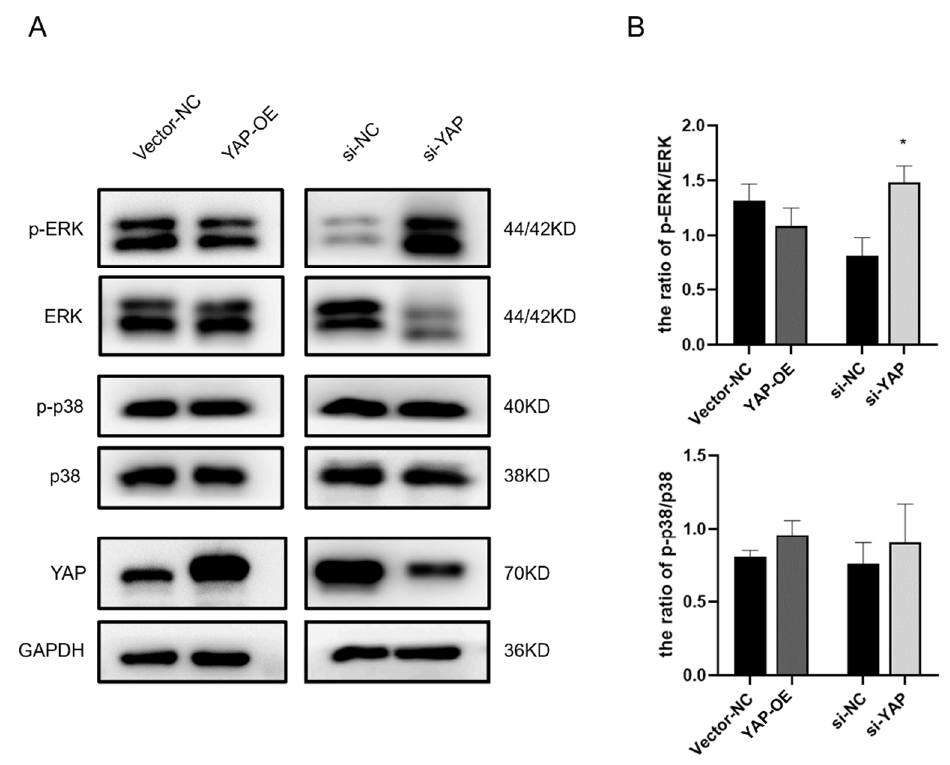
Figure 6. The phosphorylation of MAPK-ERK ascends after YAP inhibition in HTR-8 cells. YAP-OE plasmid (YAP-OE) or YAP siRNA (si-YAP) were transfected into HTR-8 cells which were harvested after 72 h. ( A ) Immunoblotting of the p-ERK, ERK, p-p38, and p38 proteins in YAP-OE or si-YAP HTR-8 cells. ( B ) p-ERK and p-p38 protein levels were normalized to ERK or p38 protein levels. GAPDH served as internal control. All values are presented as mean ± SEM. Student’s t test; * p < 0.05.